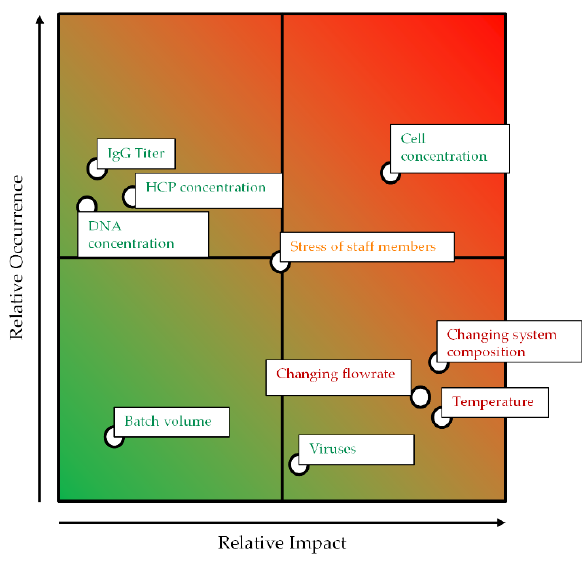
Figure 4. Occurrence–impact diagram for the outlined ATPE process.